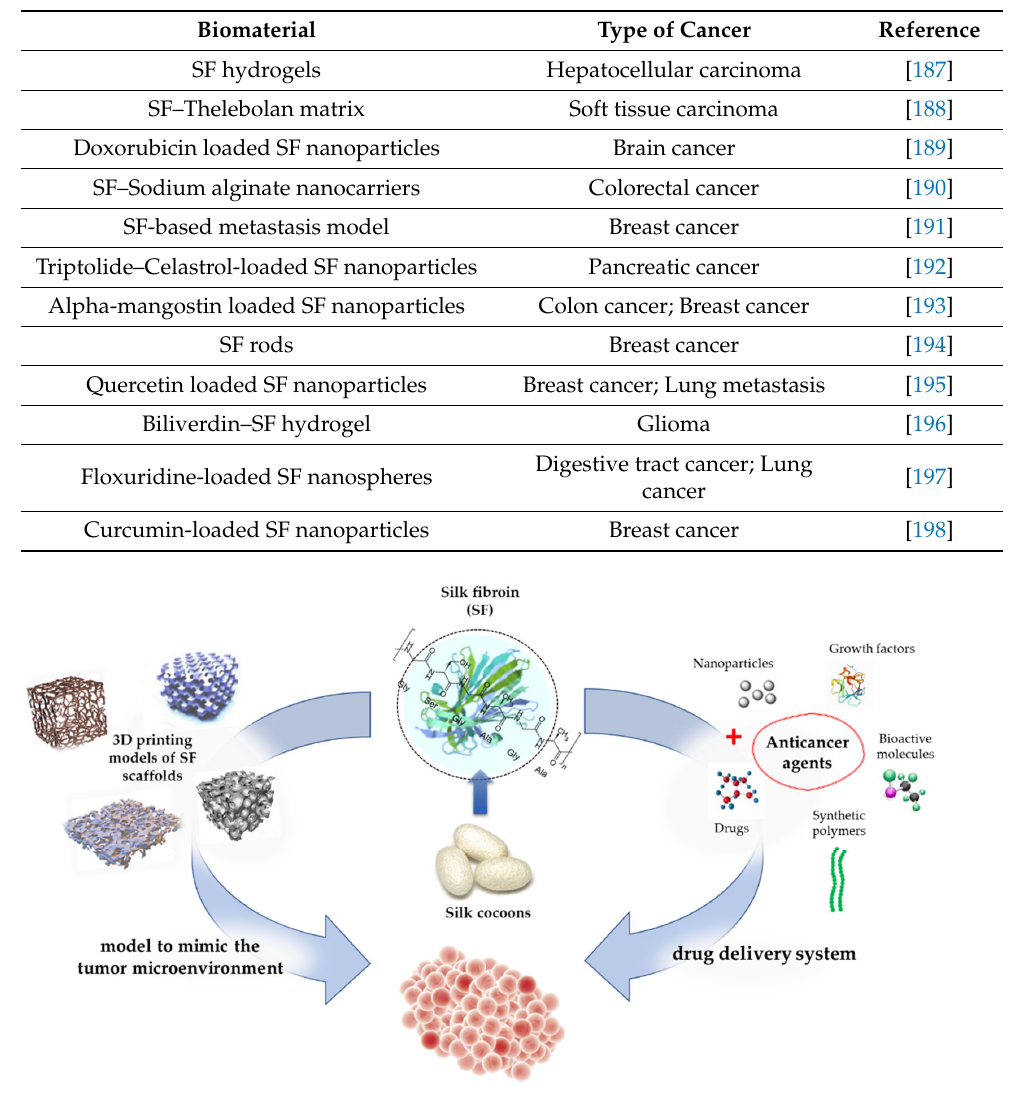
Figure 6. SF ‐ based drug delivery and the production of 3D SF scaffolds for the growth of cancer